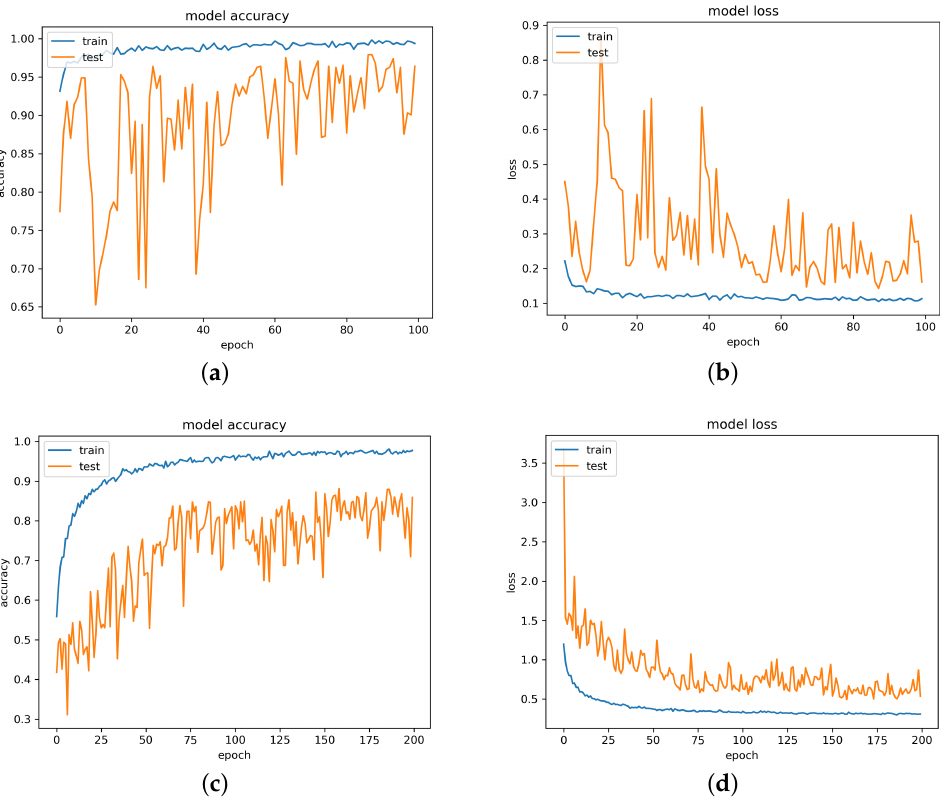
Figure 7. BNN model training results: ( a , b ) show BNN model accuracy and loss on defects identification (defective or defect-free); ( c , d ) show BNN model accuracy and loss on defect type